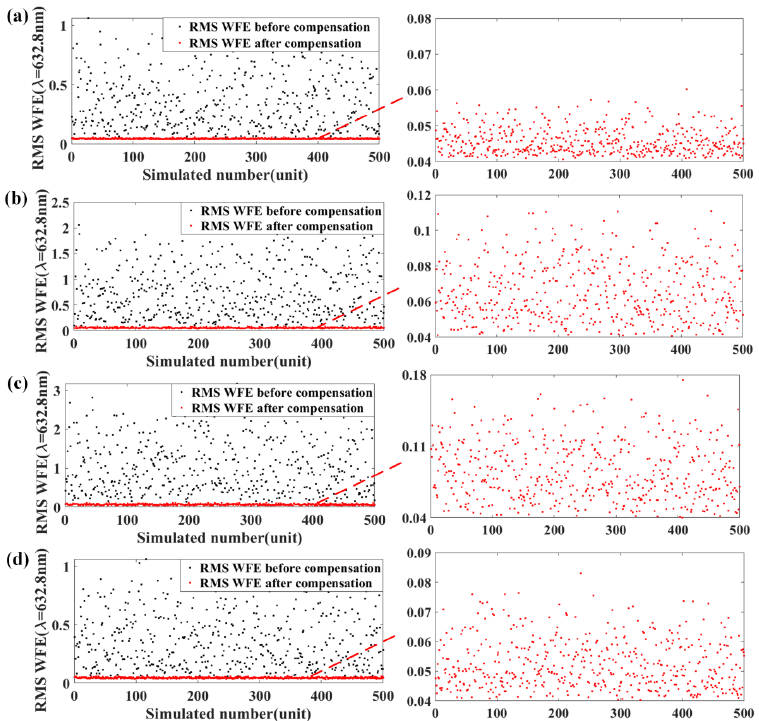
Figure 7. Average RMS WFE before and after compensation of the optical system based on TMCM: ( a ) Case 1, ( b ) Case 2, ( c ) Case 3, and ( d ) Case 4. It could be noted that the black and red spots represent the average RMS WFE before and after compensation, respectively. Table 4. The RMSD of SMCM and TMCM in different cases.